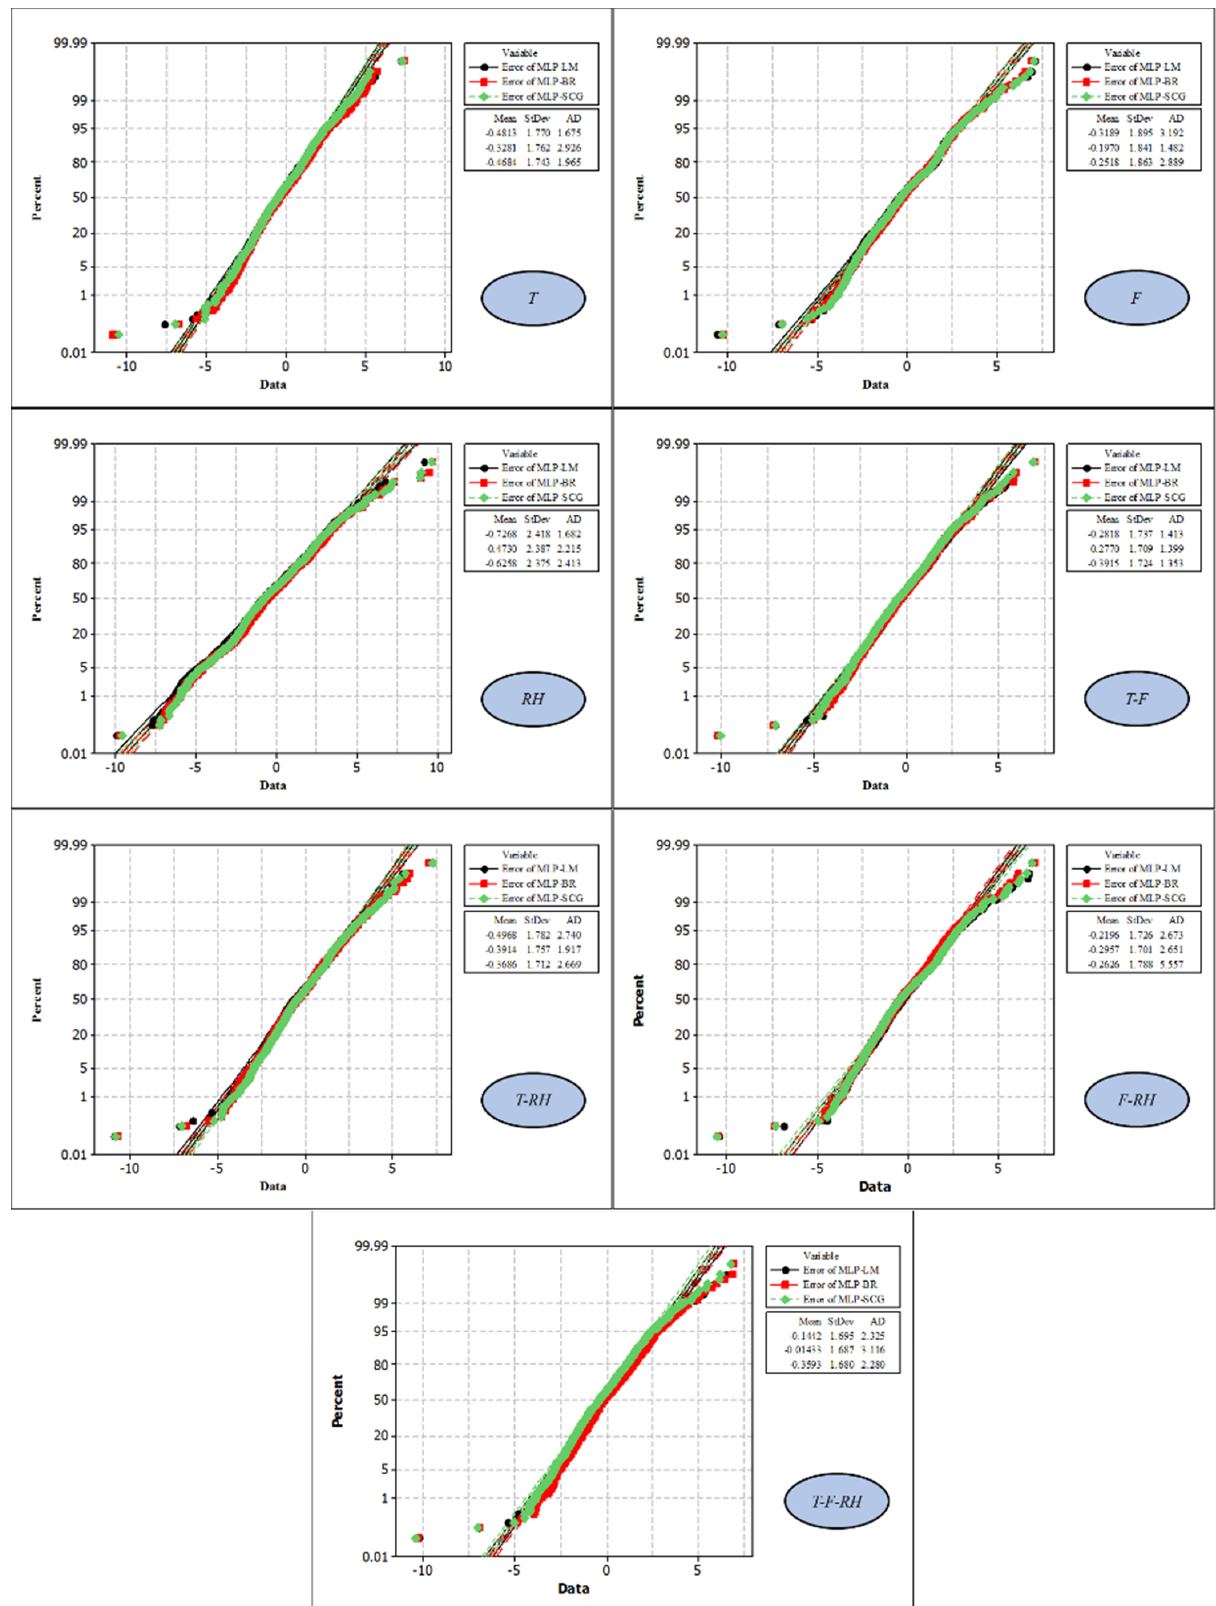
Figure 9. Probability plots for the normal distribution of the modeling errors.